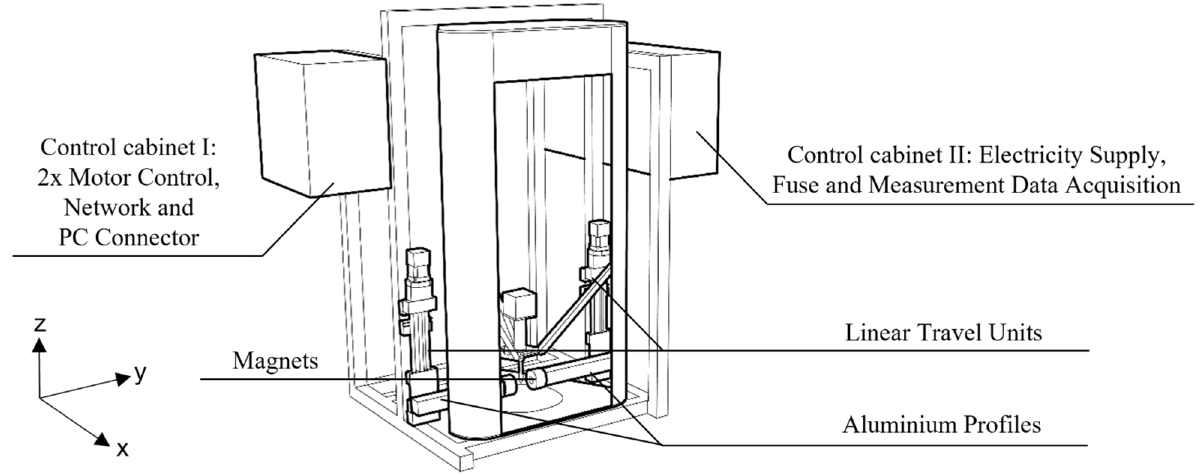
Figure 1. Construction system of the Delta 3D printer with the additional module installed.